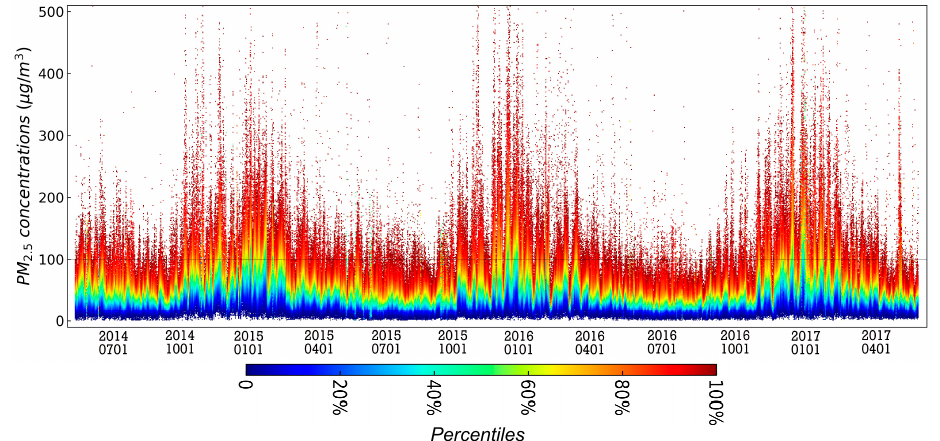
Figure 2. The time series chart of the ground monitor station date of daily average PM 2.5 concentration from 13 May 2014 to 30 May 2017 in mainland China. The color represents the percentile.